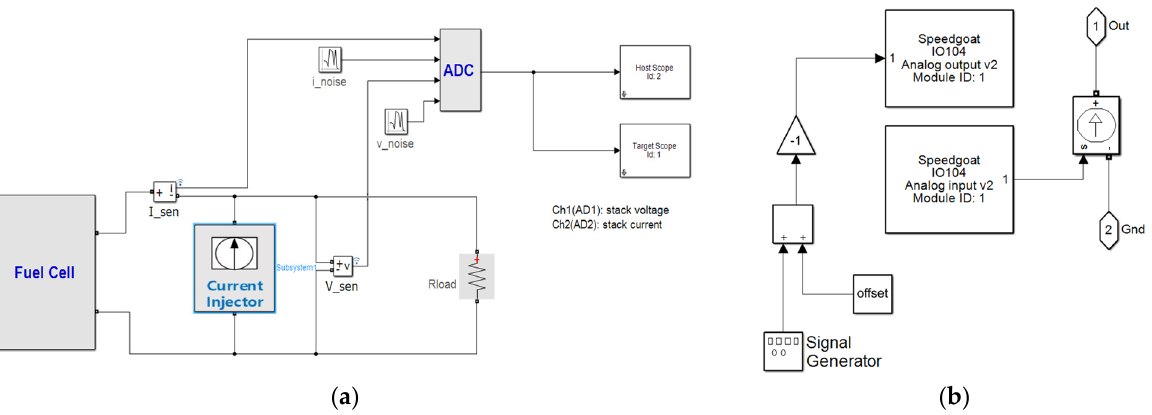
Figure 6. Simulink model for a real-time simulation test. ( a ) Simulink model. ( b ) Modified current injector model.